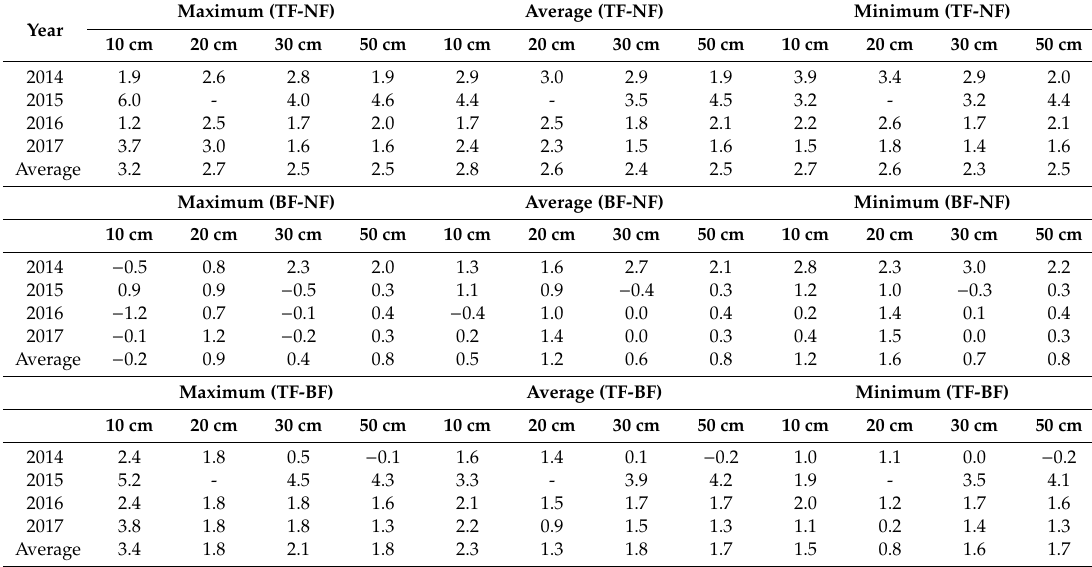
Table 4. The soil temperature (T) (daily maximum T, daily average T, and daily minimum T) di ff erences between di ff erent treatments: black film (BF), no film (NF), and transparent film (TF) at 10 cm soil depth during the early 30 days after potato growth in